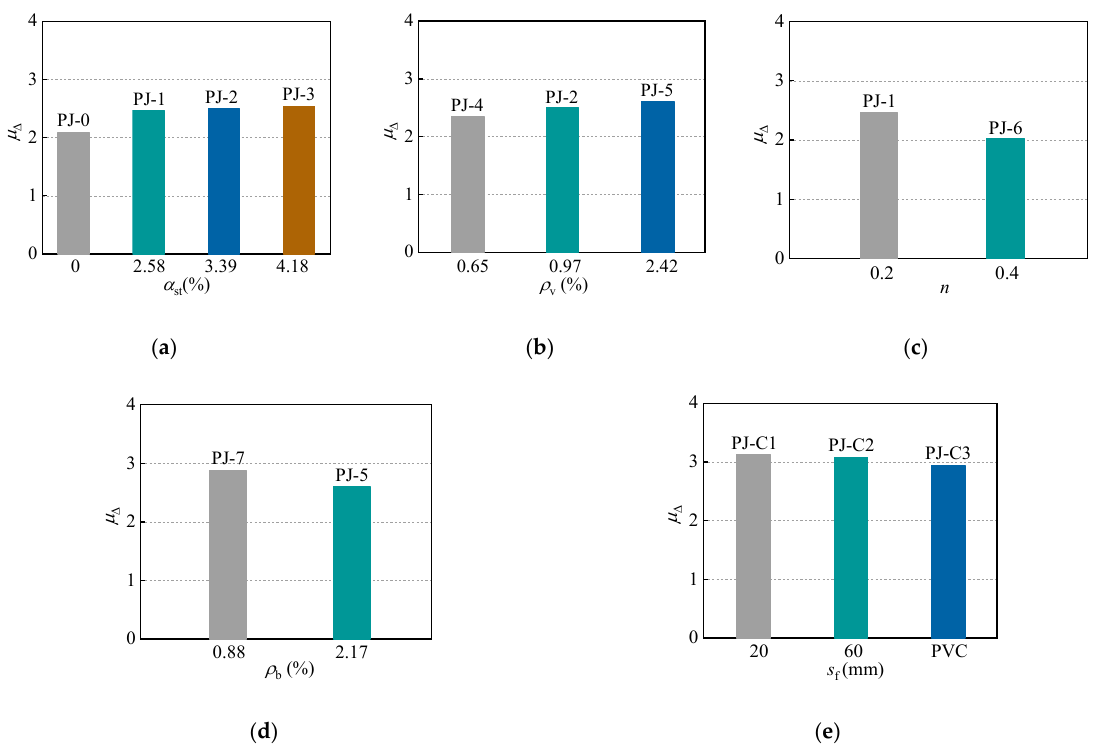
Figure 9. Effects of design parameters on the ductility coefficients. ( a ) Steel ratio of STC. ( b ) Stirrup ratio of the joint. ( c ) Axial compression ratio. ( d ) Reinforcement ratio of the frame beam. ( e ) CFRP strips spacing.